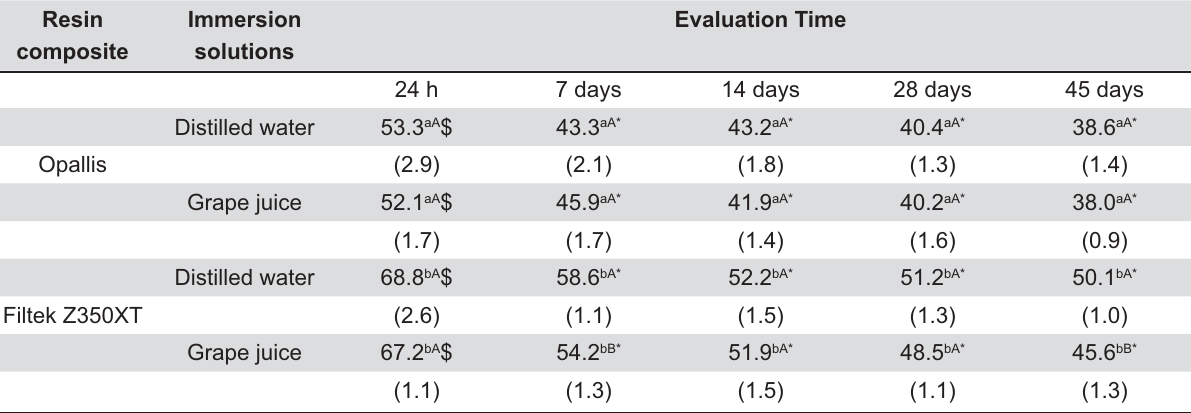
Table 1- Means (standard deviations) of hardness (KHN) of the tested resin composites as a function of the immersion solutions and evaluation